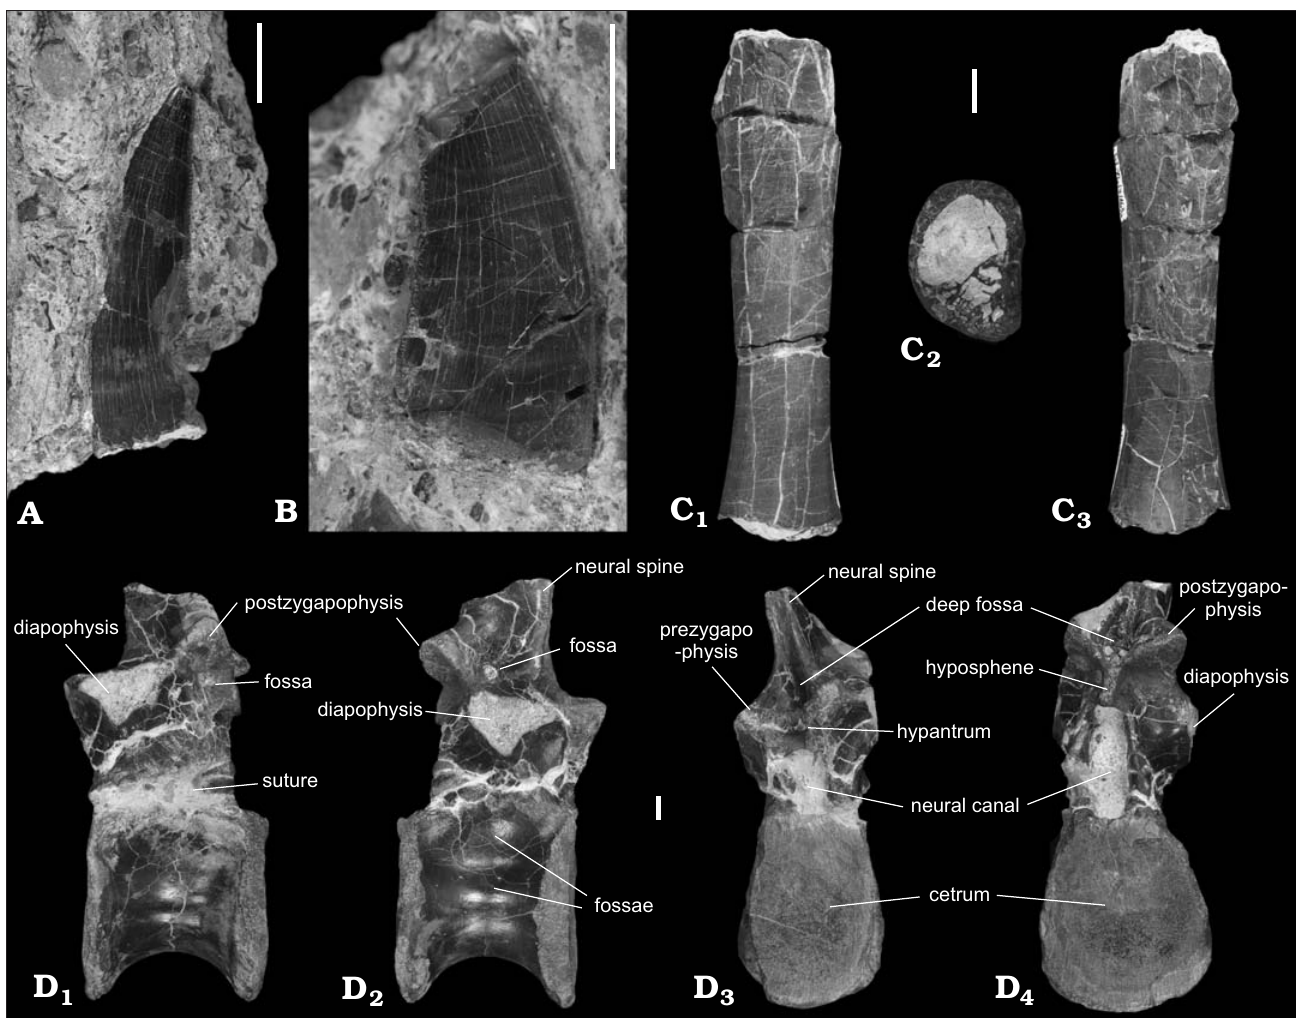
Fig. 2. Predatory archosaur Smok sp., Marciszów near Zawiercie, Poland, Late Triassic. A , B . Isolated teeth in lateral view ( A , WNoZ/S/7/192; B , WNoZ/S/7/198). C . Mid-shaft of the humerus (WNoZ/S/7/163), in posterior (C 1 ) and anterior (C 2 ) views, distal cross section (C 3 ). D . Mid-dorsal vertebra (WNoZ/S/7/199), in left (D 1 ) and right (D 2 ) lateral, anterior (D 3 ), and posterior (D 4 ) views. Scale bars 10